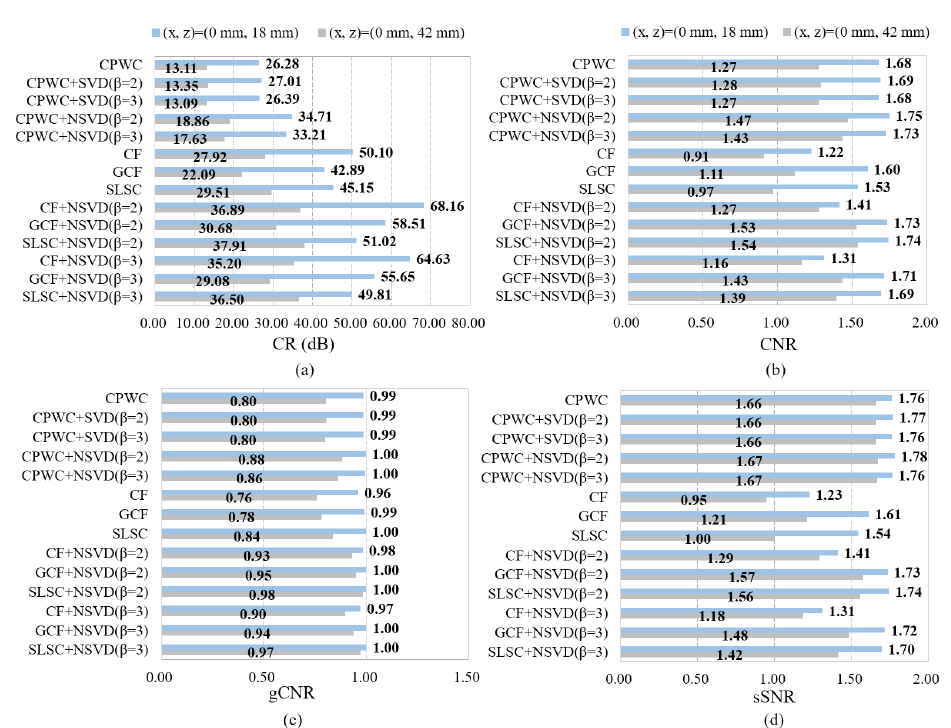
Figure 7. ( a ) CR, ( b ) CNR, ( c ) gCNR, and ( d ) sSNR for each beamforming method in images of simulated phantom with cyst targets. The first and second column contain the results of anechoic cysts centered at (x, z) = (0 mm, 18 mm) and (x, z) = (0 mm, 42 mm),